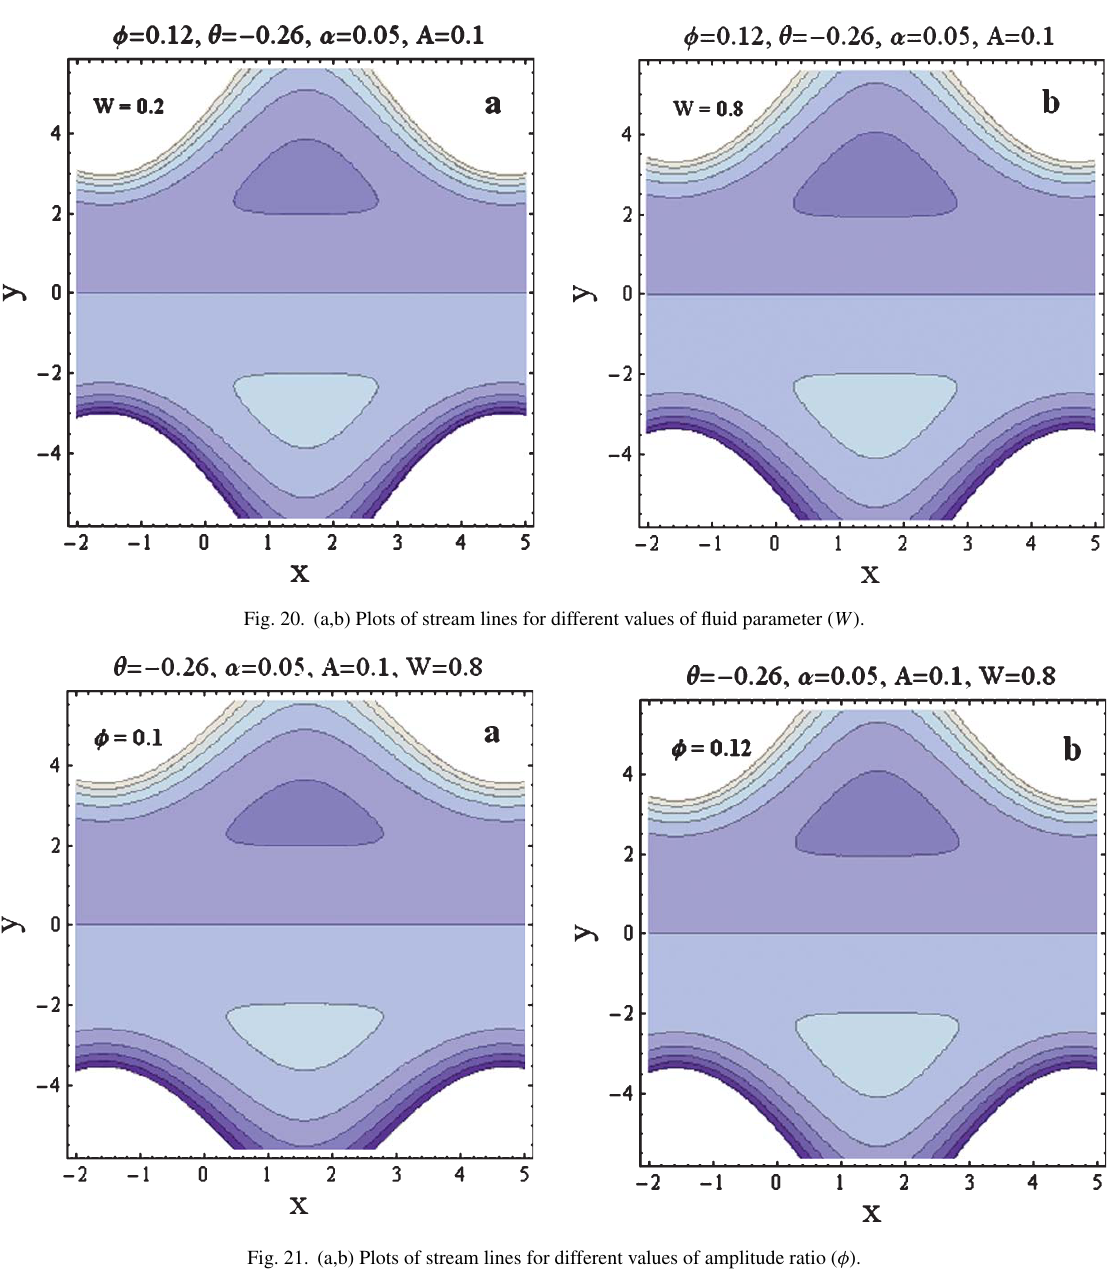
Fig. 21. (a,b) Plots of stream lines for different values of amplitude ratio ( φ